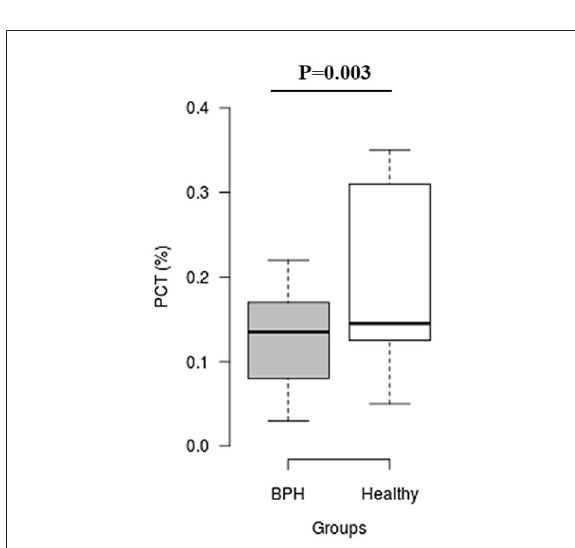
FIGURE5 Box plots of platelet counts (PLT) in BPH and Healthy groups. Center lines show the medians; box limits indicate the 25th and 75th percentiles. n = 24, 11 sample